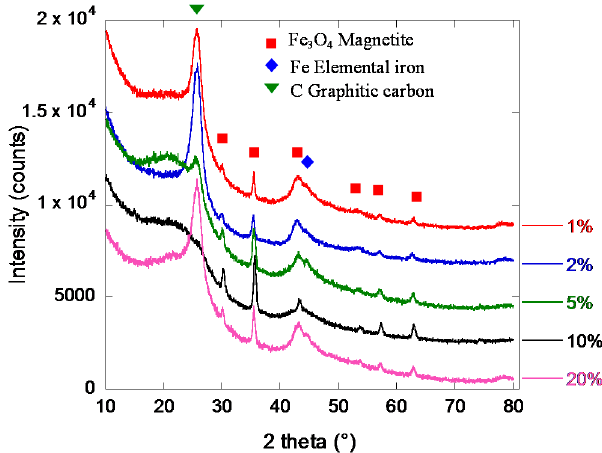
Figure 10. XRD patterns for carbon samples loaded with different percentages of iron, obtained by HTC of tannin-Fe(II) solutions, followed by pyrolysis at 900 °C under inert atmosphere. For clarity, the patterns were shifted in intensity with respect to each other.